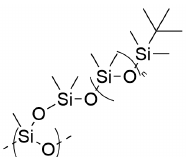
Fig. 4. Chemical structure of PDMS-g-PDMS bottlebrush polymer.[15]